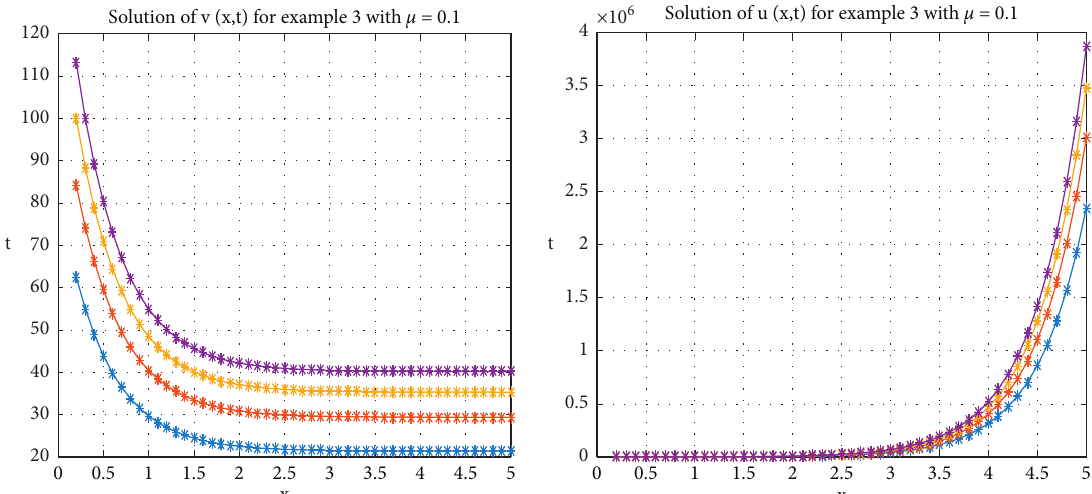
Figure 5: 2D graphical representation for u ( x,t ) and v ( x,t ) of equation (47).